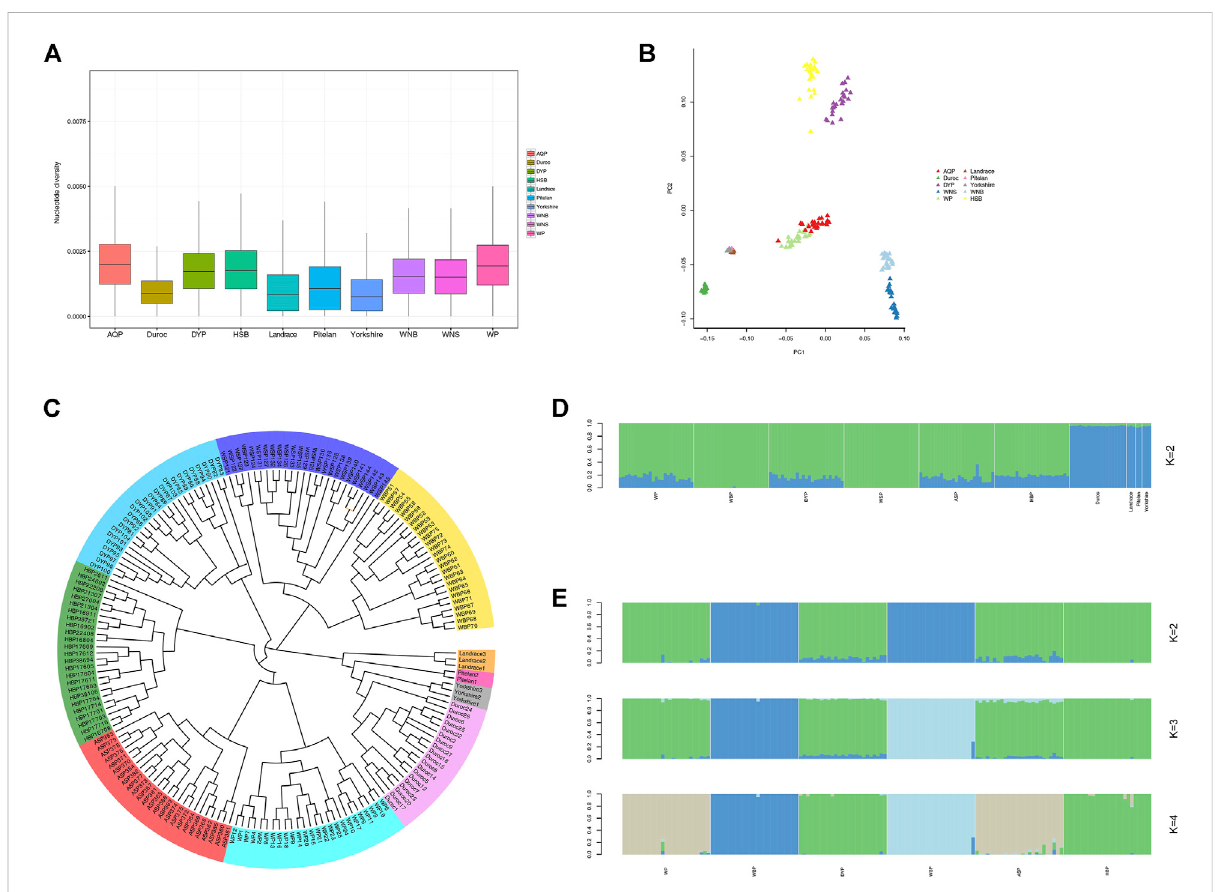
FIGURE 2 Population structure and relationship of Anhui in comparison to commercial pig. (A) Genome-wide distribution of nucleotide diversity among Anhui pig breeds and four commercial pig breeds with a 50-kb window. (B) Principal component analysis of Anhui pig breeds and four commercial pigbreeds,PC1againstPC2. (C) Neighbor-joiningtreeoftherelationshipsbetweenthetenpigpopulations.Thescalebarrepresentstheidentity-by- state(IBS)scorebetweenpairsofanimals. (D) Proportionofancestryforeachindividualassumingdifferentnumberofancestralpopulation( K